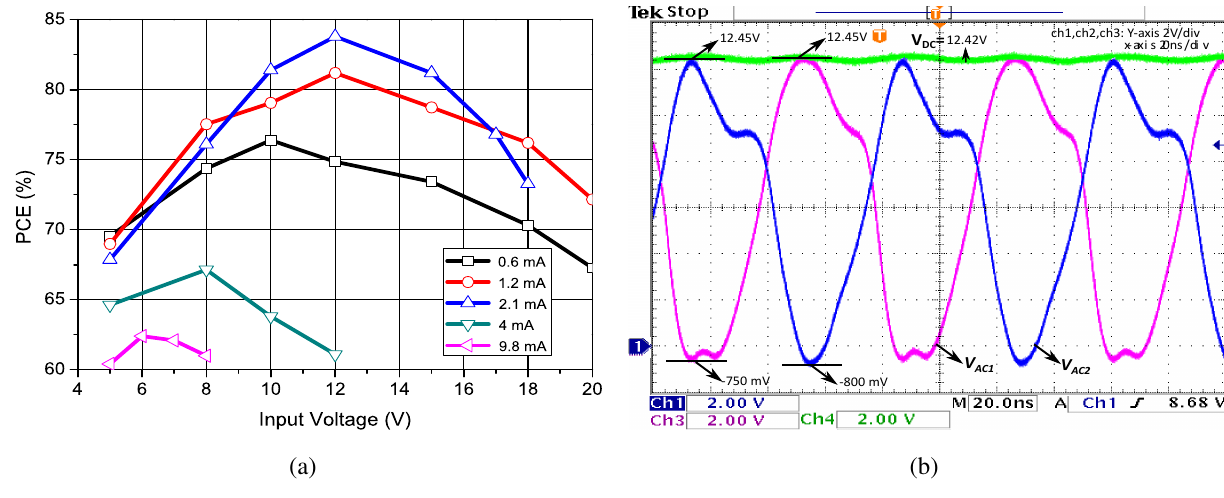
Figure 12. Experimental: ( a ) PCE with varying input voltage and load current; ( b ) oscilloscope capture of the transient response of the proposed rectifier. Table 2. Performance comparison with prior